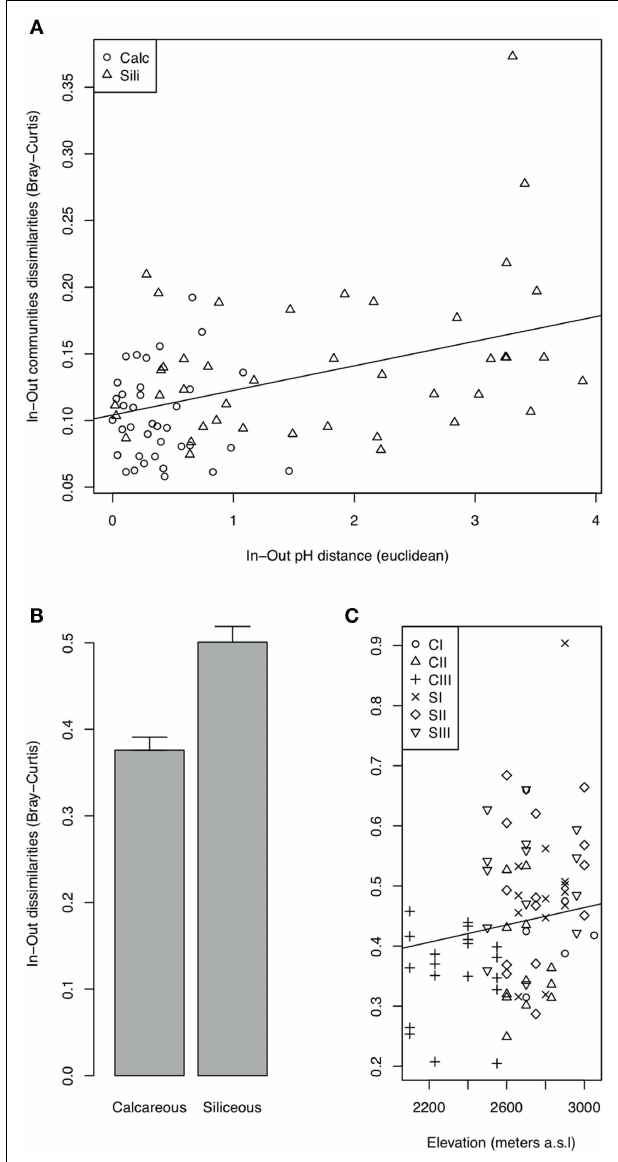
FIGURE 5 | Bacterial (A) and fungal (B,C) In-Out beta-diversity. The best AIC models indicated a relationship between the In-Out beta-diversity and the In-Out pH distance (Euclidean) for bacteria and the effect of bedrock and elevation, without an interaction for fungi ( TableA2 in Appendix).